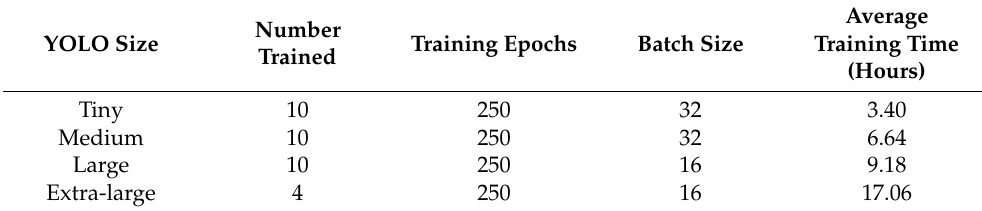
Table 1. YOLO model training summary (desktop PC).